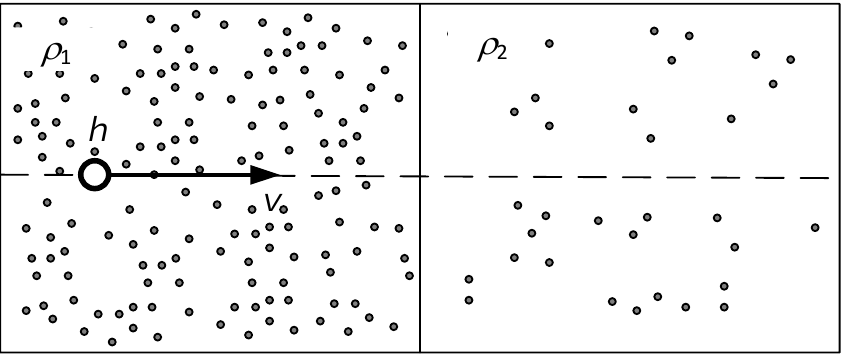
Figure 7 . MCH movement through two areas with different densities of network nodes . Figure 7. MCH movement through two areas with different densities of network